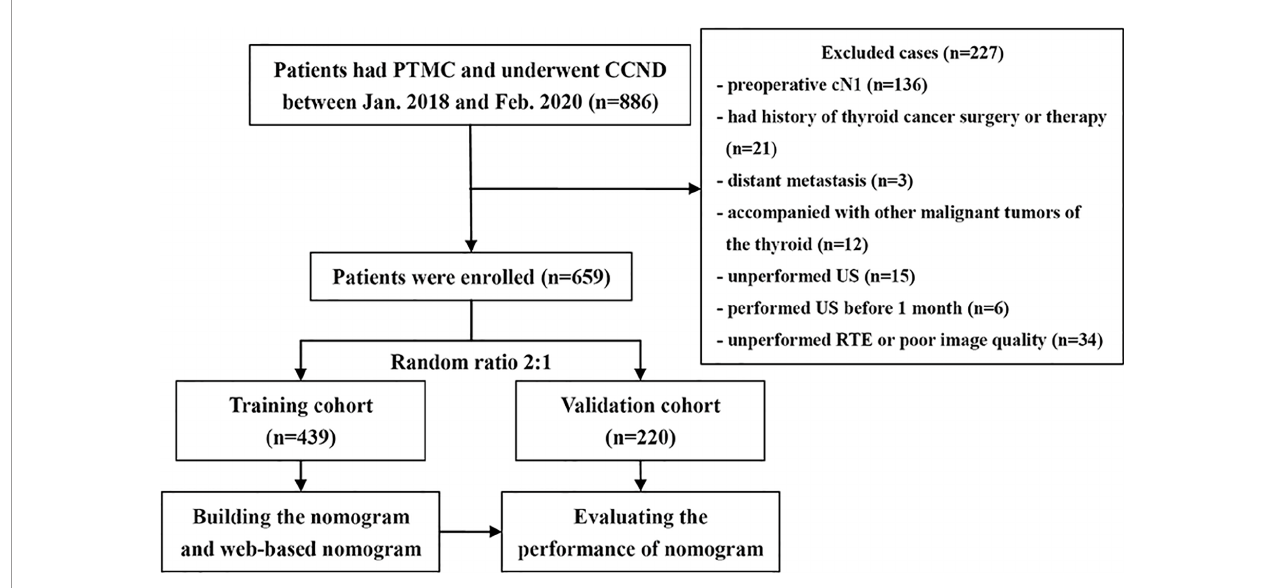
FIGURE 1 | Flowchart of enrolled cN0 papillary thyroid microcarcinoma